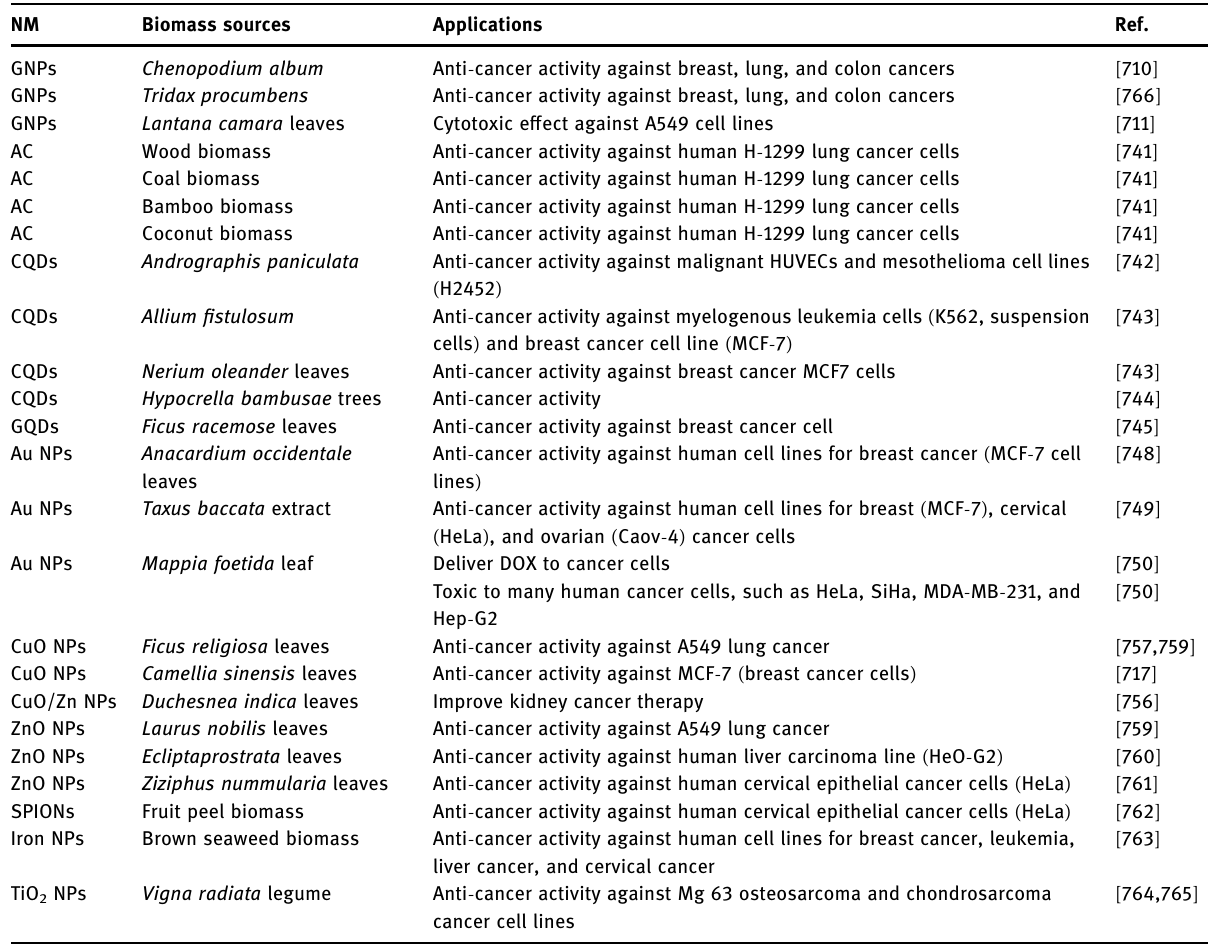
Table 15: Application of recycled NPs as therapeutic anti - cancer agents